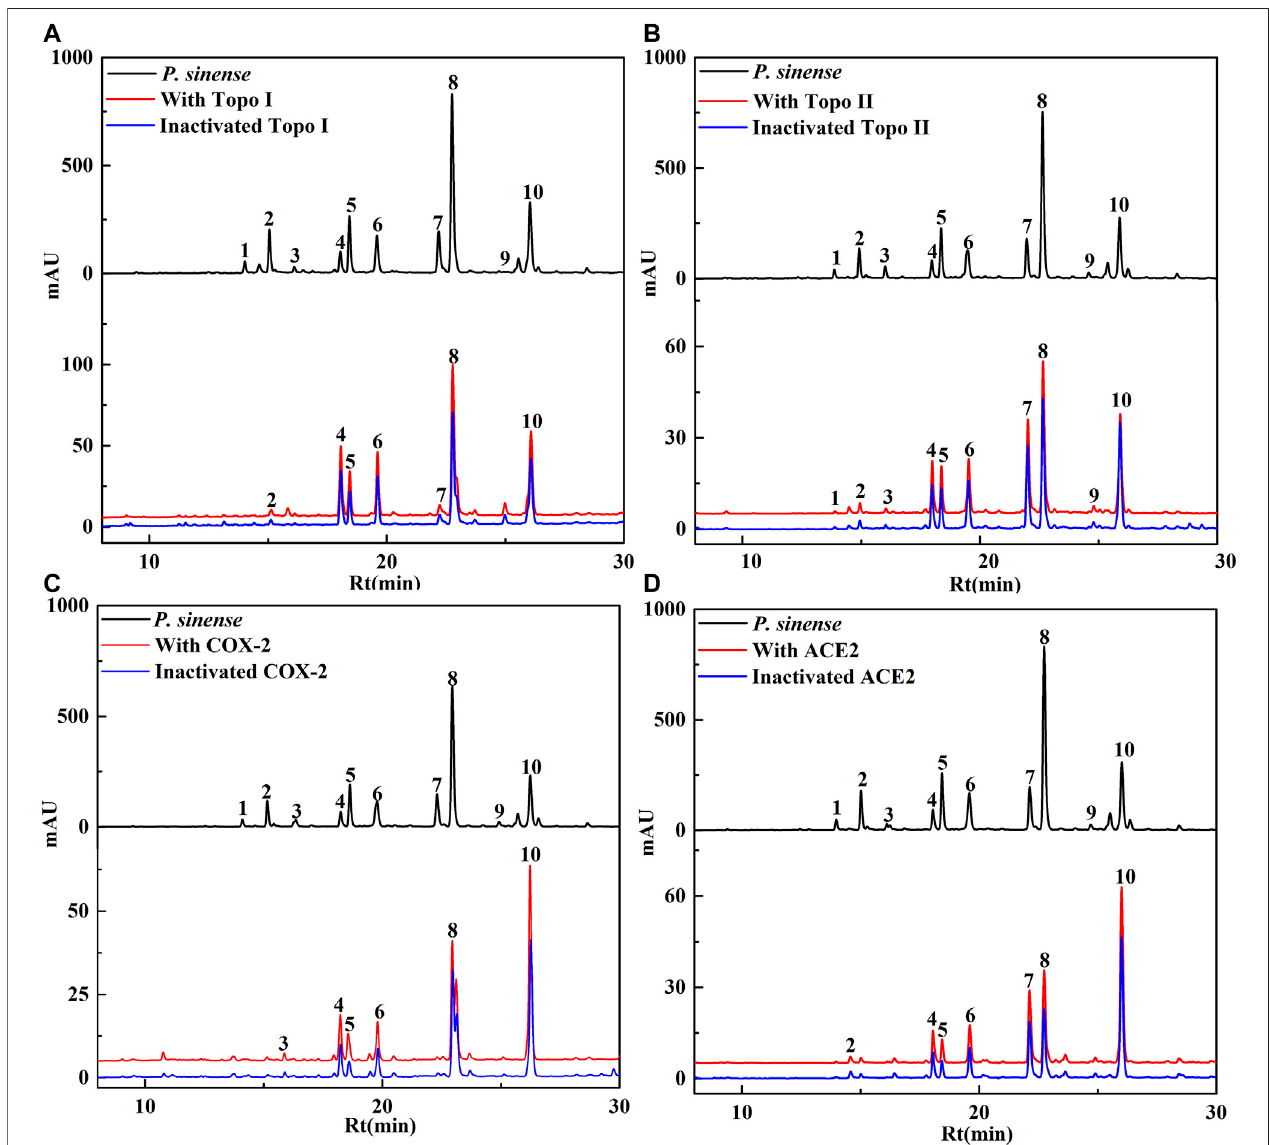
FIGURE 1 | HPLC chromatograms of the chemical constituents in P. sinense were obtained after ultra fi ltration at 292 nm. The black solid line represents HPLC pro fi lesofthecrudeextractsof P.sinense withoutultra fi ltration;theredlineandbluelinerepresentthetotalextractof P.sinense withactivatedandinactivatedTopoI (A) , Topo II (B) , COX-2 (C) , and ACE2 (D) , respectively.